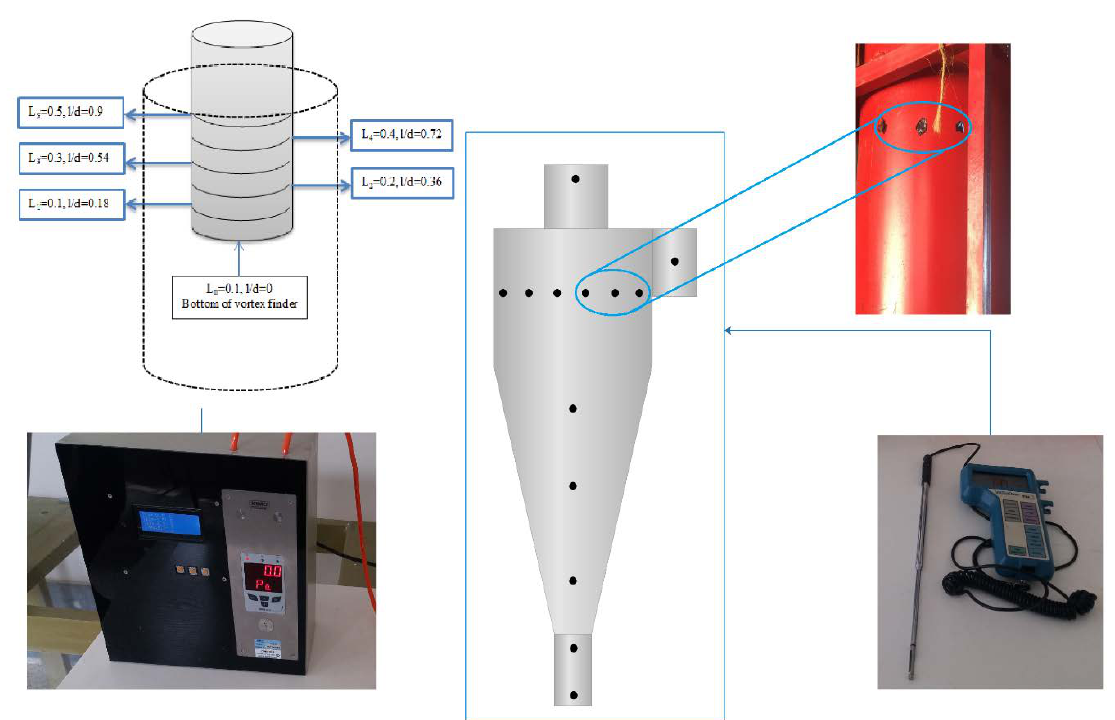
Figure 2. Experimental set-up for validation process.